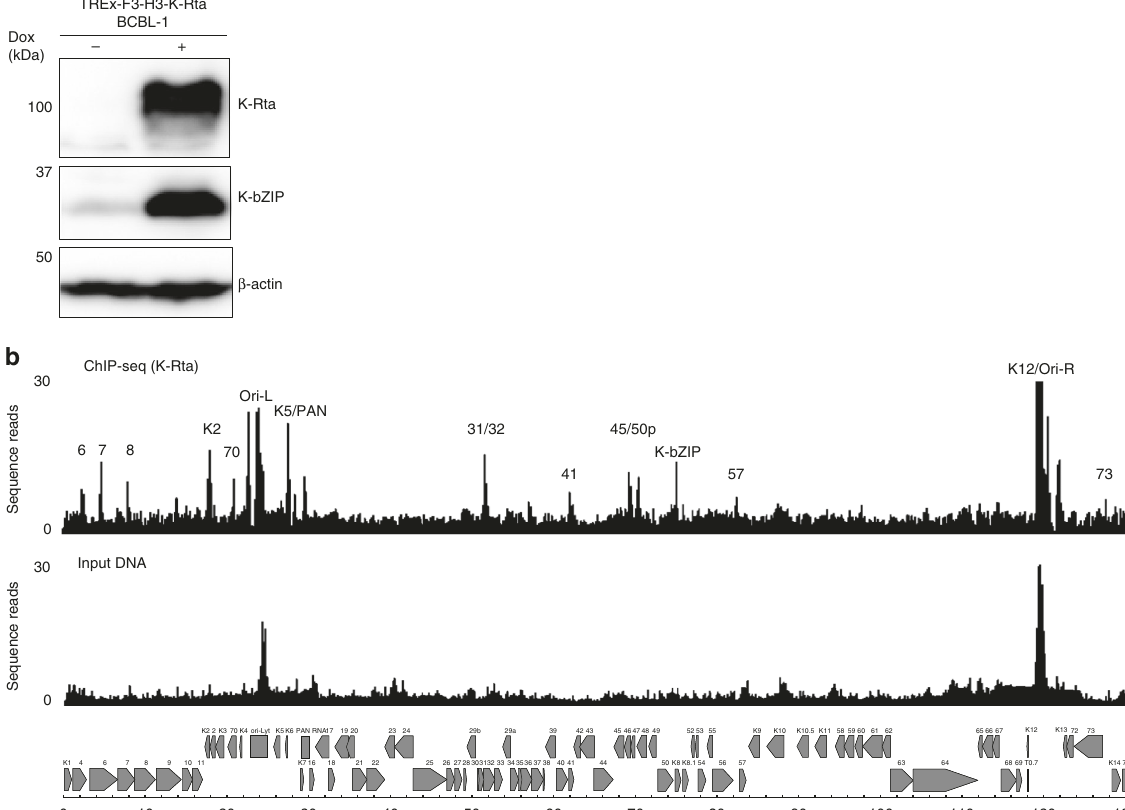
Fig. 1 K-Rta recruitment sites on the KSHV genome KSHV reactivation. a KSHV lytic protein expression in TREx-K-Rta BCBL − 1 cells during latency ( − ) and at 24 h post-dox treatment (+) was examined by immunoblotting. Blots were probed with the indicated antibodies. b K-Rta recruitment sites were examined by ChIP-sequencing analysis using K-Rta ChIP DNA prepared from TREx-K-Rta BCBL − 1 cells 24 h post-dox treatment. Peak fi nding was performed with MACS2 program using the default parameter settings. Peaks mapped to the KSHV genome are plotted and the location of the each peak